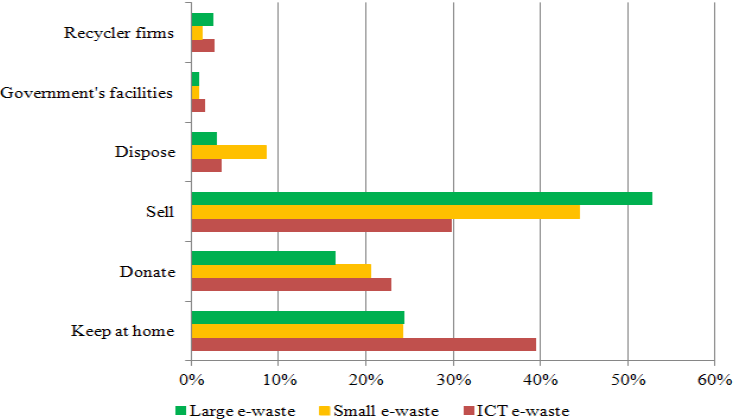
Fig. 3: Methods to discharge e-waste